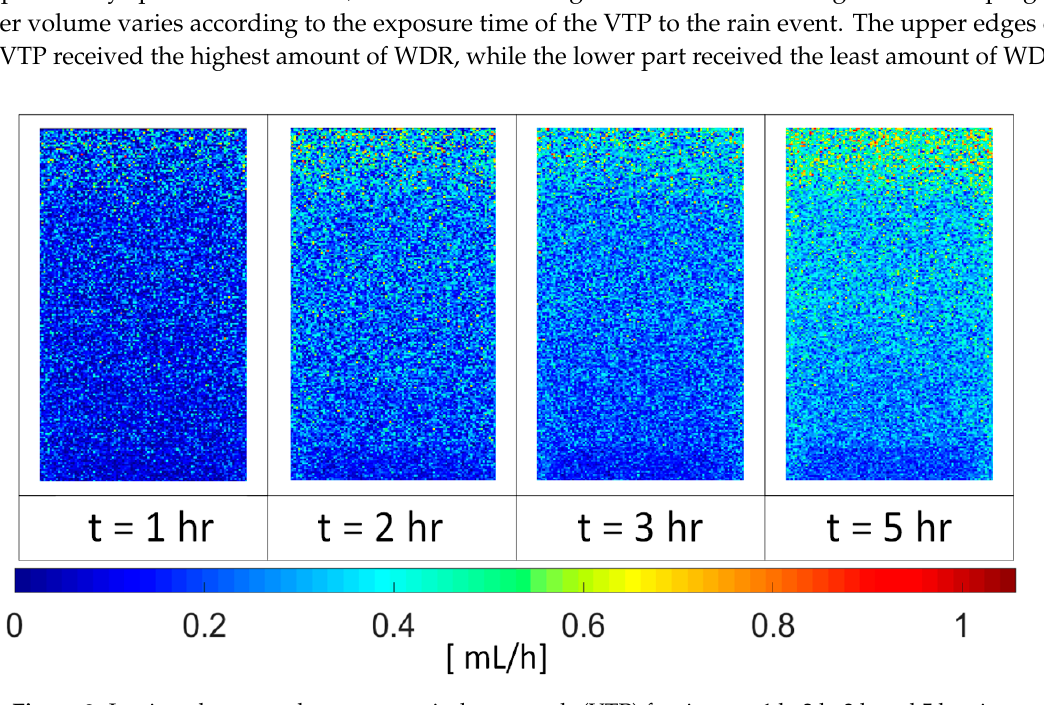
Figure 2. Impinged water volumes on vertical test panels (VTP) for time t = 1 h, 2 h, 3 h and 5 h using the wind-driven rain Computational Fluid Dynamics (CFD) model by Blocken [30].